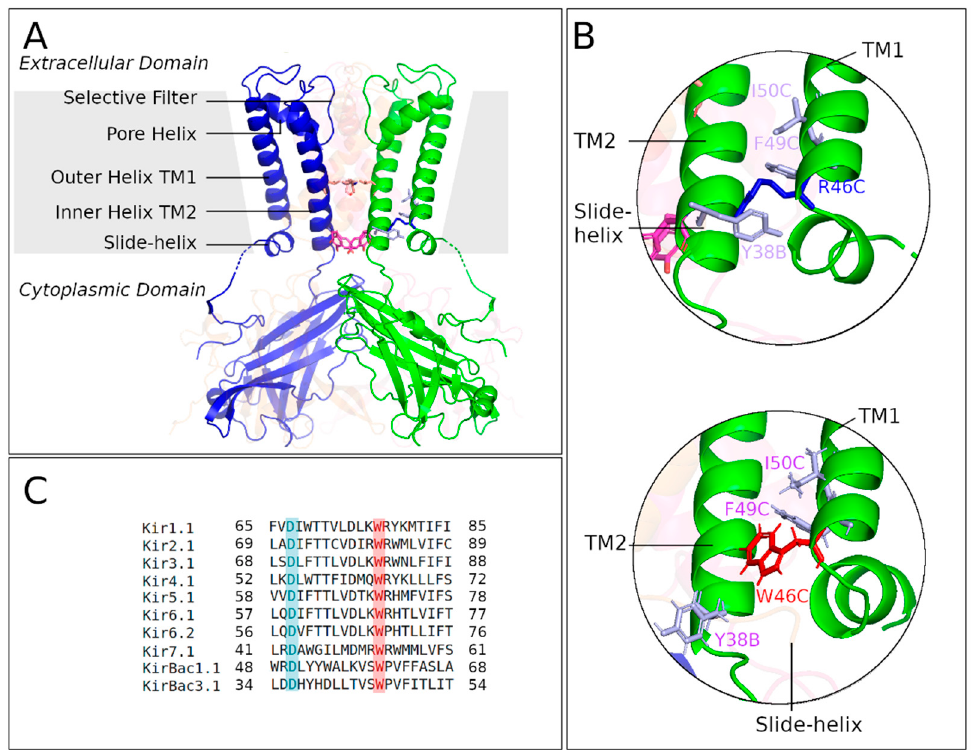
Figure 1. Crystallographic structure of KirBac3.1 W46R (PDB 7ADI). ( A ) Structure of KirBac3.1 W46R showing the location of the mutant R46 at the bottom of TM1. The gray area represents the membrane, and arrows indicate the various domains in the figure. Orange and magenta residues at the center of the channel correspond to the constriction points Leu124 and Tyr132, respectively. For clarity, two subunits out of four are represented. ( B ) Top: Zoom on the area around the mutation R46 (blue) at the bottom of TM1 from chain C (R46-C) interacting with Y38-B on the slide helix of the n-1 chain (chain A counterclockwise neighbor chain). Bottom: Same area as above with KirBac3.1 WT (PDB 2WLJ). W46-C (chain C, in red) in the “flipped-in” conformation packed against the C-terminal end of TM2 (chain B). ( C ) Alignment for Kir channels sequences. The tryptophan residue at the position corresponding to W68 in Kir6.2, at the bottom of TM2, is absolutely conserved (pink). The aspartate residue at the position corresponding to D58 in Kir6.2, on the slide helix is also highly conserved (cyan); note that the Y38 (KirBac3.1) is equivalent to F61 (Kir6.2).